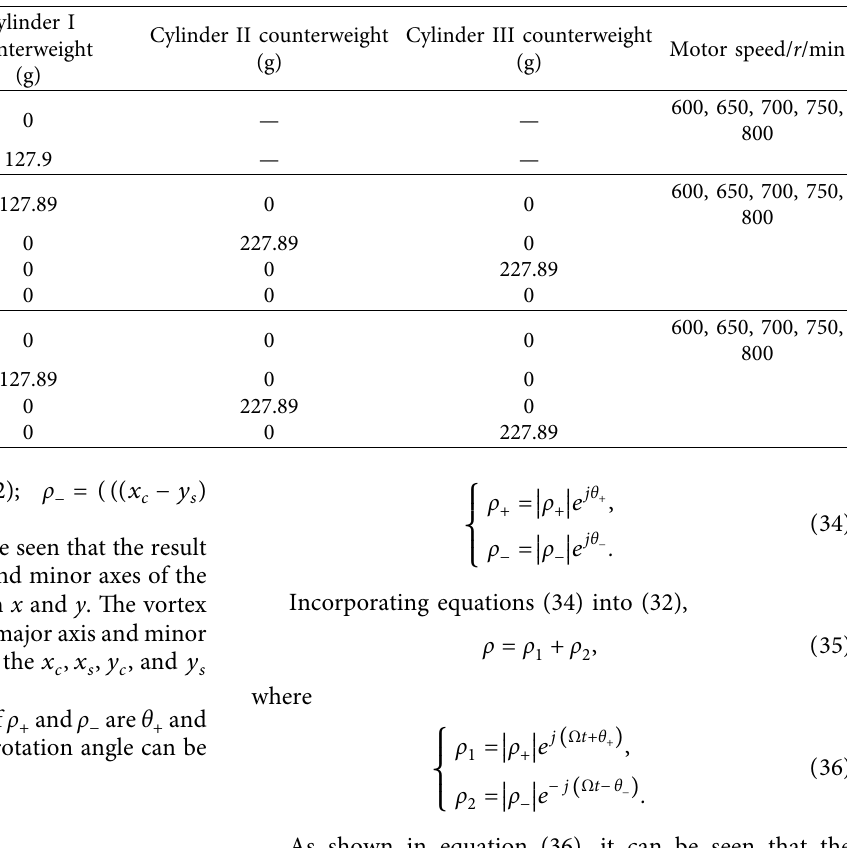
Figure 6: Test installation methods under different delivery methods. Table 2: Main working conditions during the test and the movement state of each